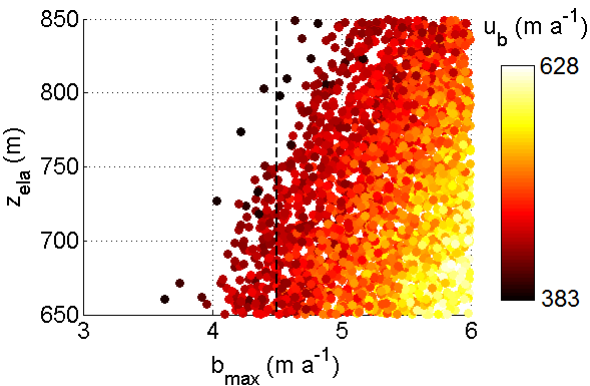
Fig. 10. Equilibrium line altitude ( z ela ) , maximum surface mass bal- ance rate ( b max ; or accumulation rate) and mean basal sliding ve- locity between km50 and 60 ( u b ) in the selected ensemble of 2669 simulations. Dashed line denotes the fifth percentile of accumula- tion rate of the selected ensemble of